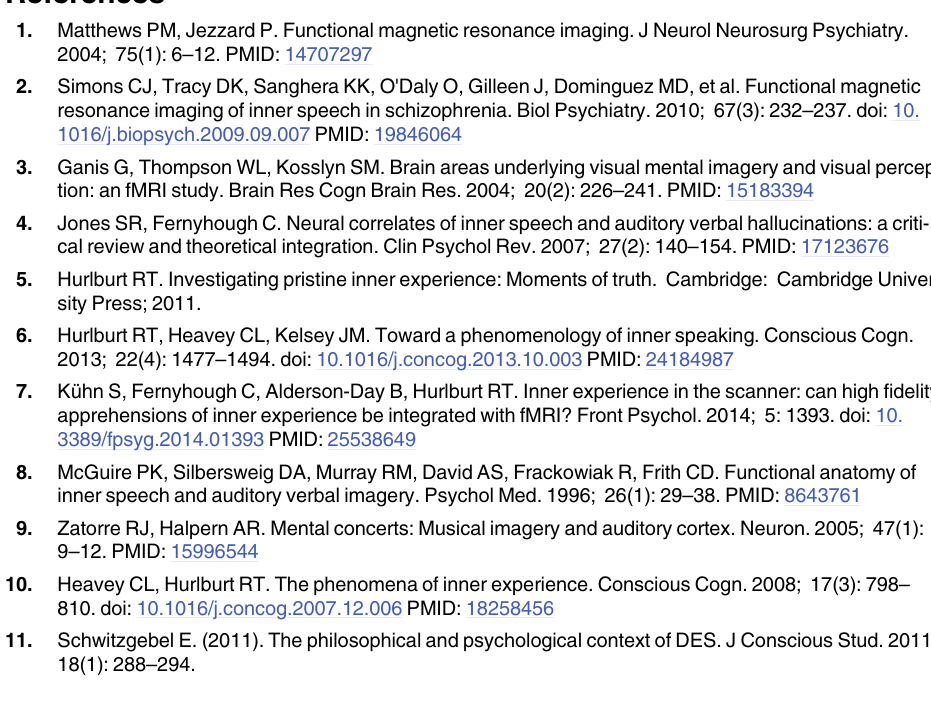
S2 Table. Participant 1 data ratings. S3 Table. Participant 2 data ratings. S4 Table. Participant 3 data ratings. S5 Table. Participant 4 data ratings. S6 Table. Participant 5 data